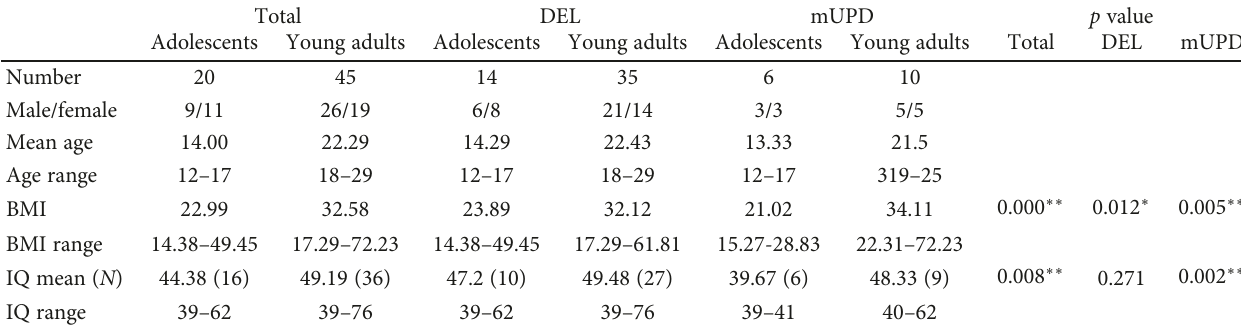
Table 1: Participants ’